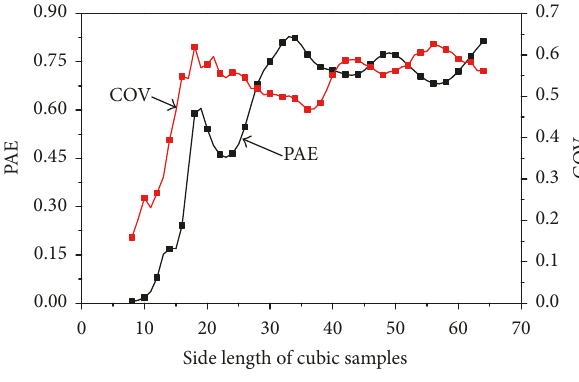
Figure 11: PAE and COV of cube.